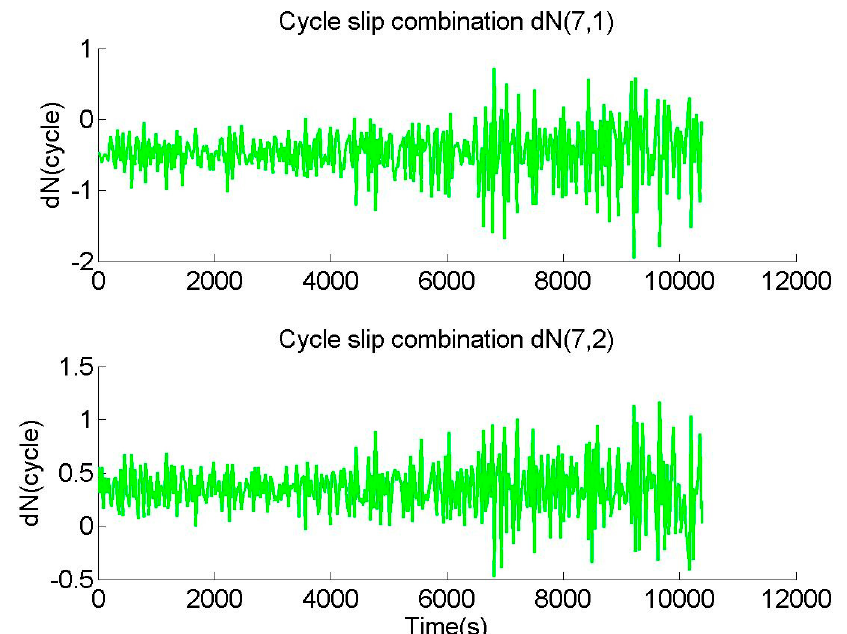
Figure 13. Floating values of the BDCSR methodology’s cycle-slip combination in the case of appending gross errors of 0.7 m on all real epoch-difference pseudoranges from MEO Satellite 11 under a weak condition of low elevations during the geomagnetic storm, where the phase data without cycle slip was collected at the CUT0 station started from UTC 8 May 2016 00:00:00 with an interval of 30 s.